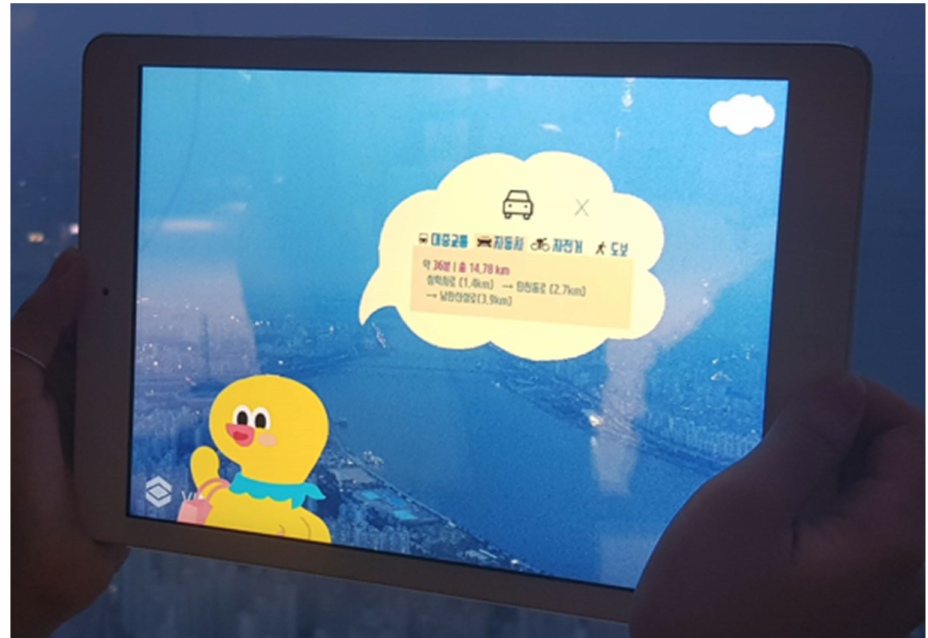
Figure 9. Users can view traffic information, tourist information, and information regarding recom- mended restaurants near the